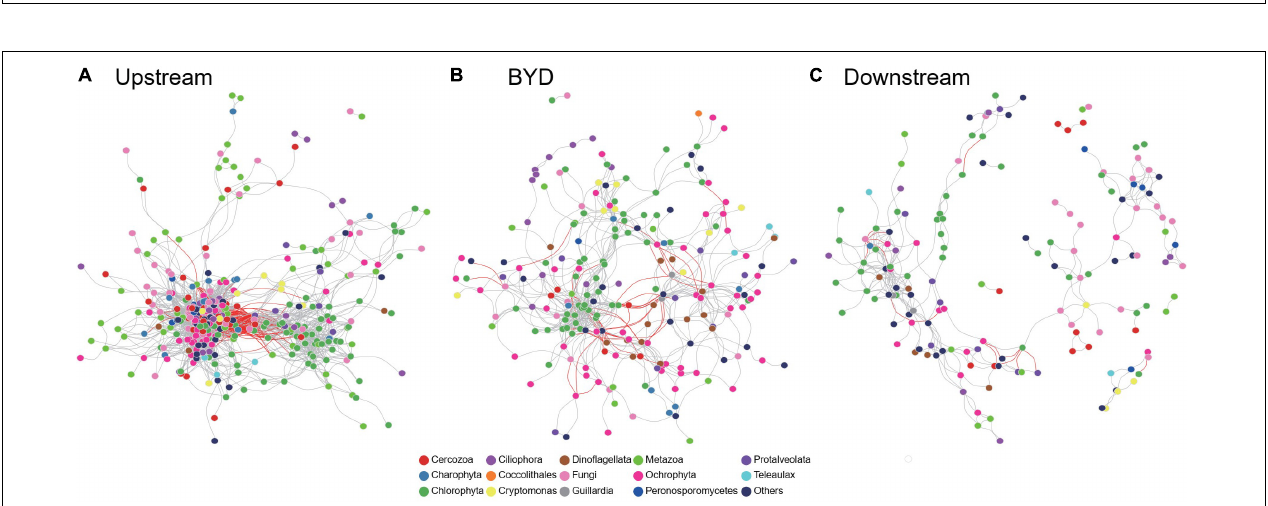
FIGURE 5 | (A) Ternary plot of the OTUs in major modules of the co-occurrence network for the whole microeukaryotic communities of three area. Chord diagrams showing the taxonomic composition of (B) module-A, (C) module-B, and (D) module-C.